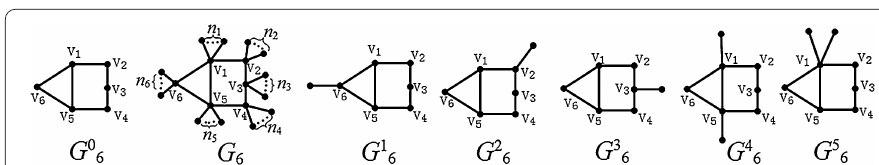
Figure 8 Some bicyclic graphs with θ (2,3,5) as their